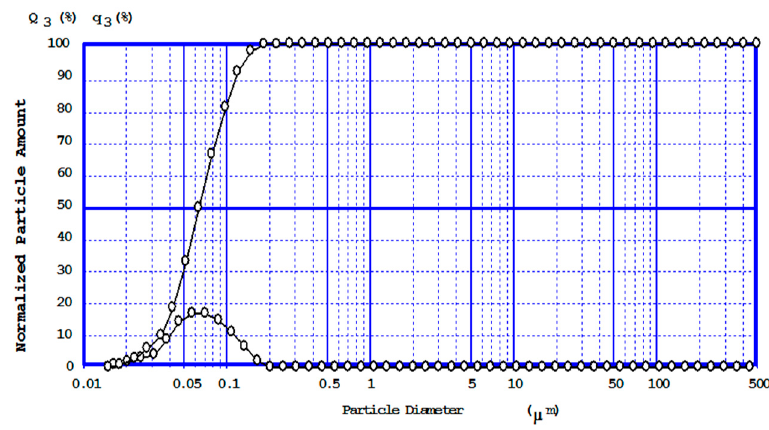
Figure 3. Particles size distribution of precipitated calcium carbonate (particle diameters and cumulative curve)